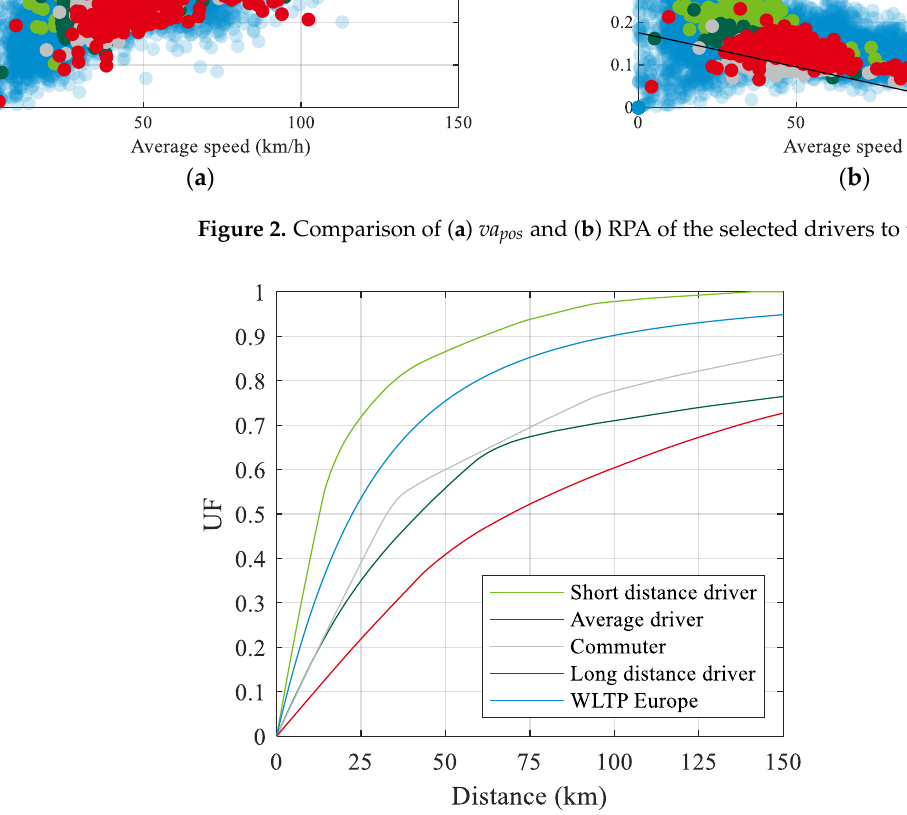
Figure 3. Utility factor curves for different use cases in comparison to the WLTP Europe curve.